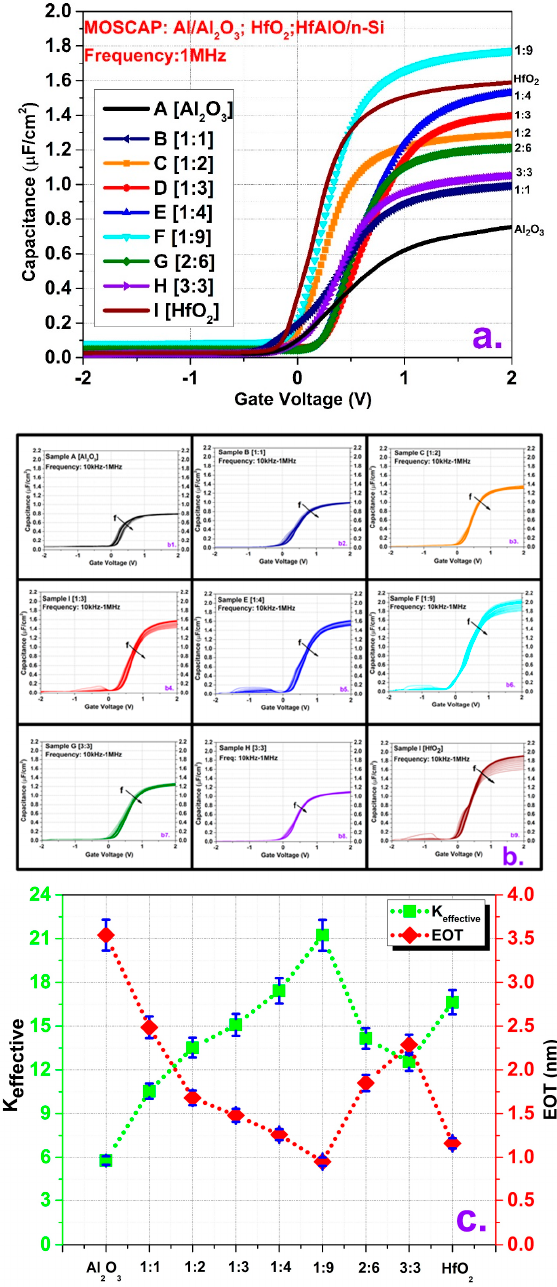
Figure 1. ( a ) Capacitance–voltage (C–V) behavior of the HfAlO MOS capacitors with single Al 2 O 3 and HfO 2 ones at 1 MHz frequency. ( b ) Multifrequency (10 kHz–1 MHz) capacitance–voltage (C–V) response of all deposition cases. ( c ) Extracted dielectric constant ( k ) and equivalent-oxide-thickness (EOT) values for all reported